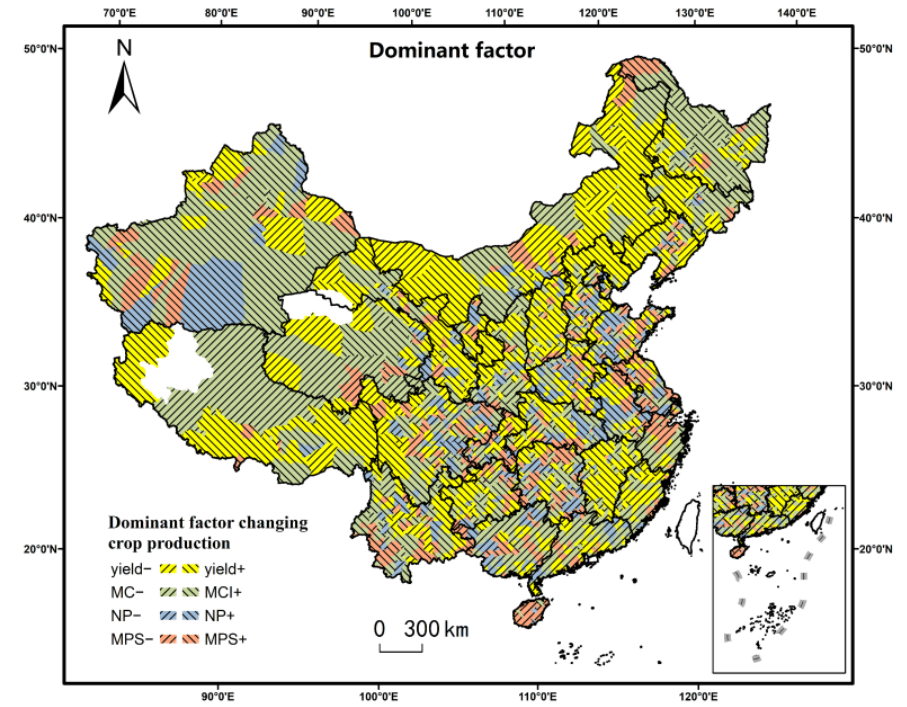
Figure 8. Spatial pattern of the dominant factors influencing crop production in China. Colors represent the dominant factor, whereas hatching indicates the overall crop production trend (i.e., “+” is net increase and “ − ” is net decrease in crop production).